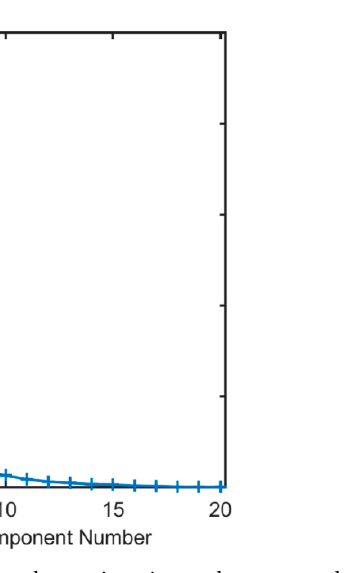
Figure A4. Hotelling T 2 v. Qresidual values of PCA model for XRD; arrows indicate copper and gold samples with unique characteristics as identified by the PCA XRD model.